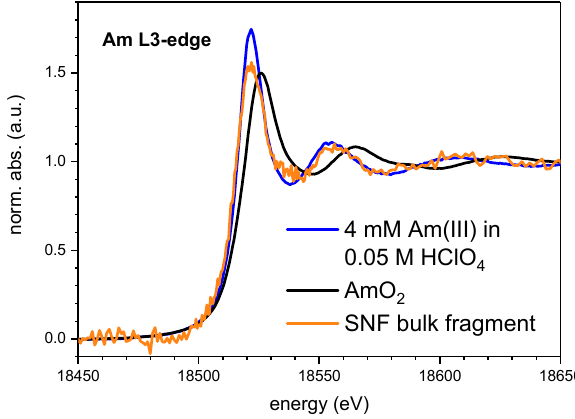
Figure 8. Am L3-XANES obtained for the Gösgen fuel fragment (orange trace) together with Am(IV) oxide (black) and Am(III)aq references (blue).